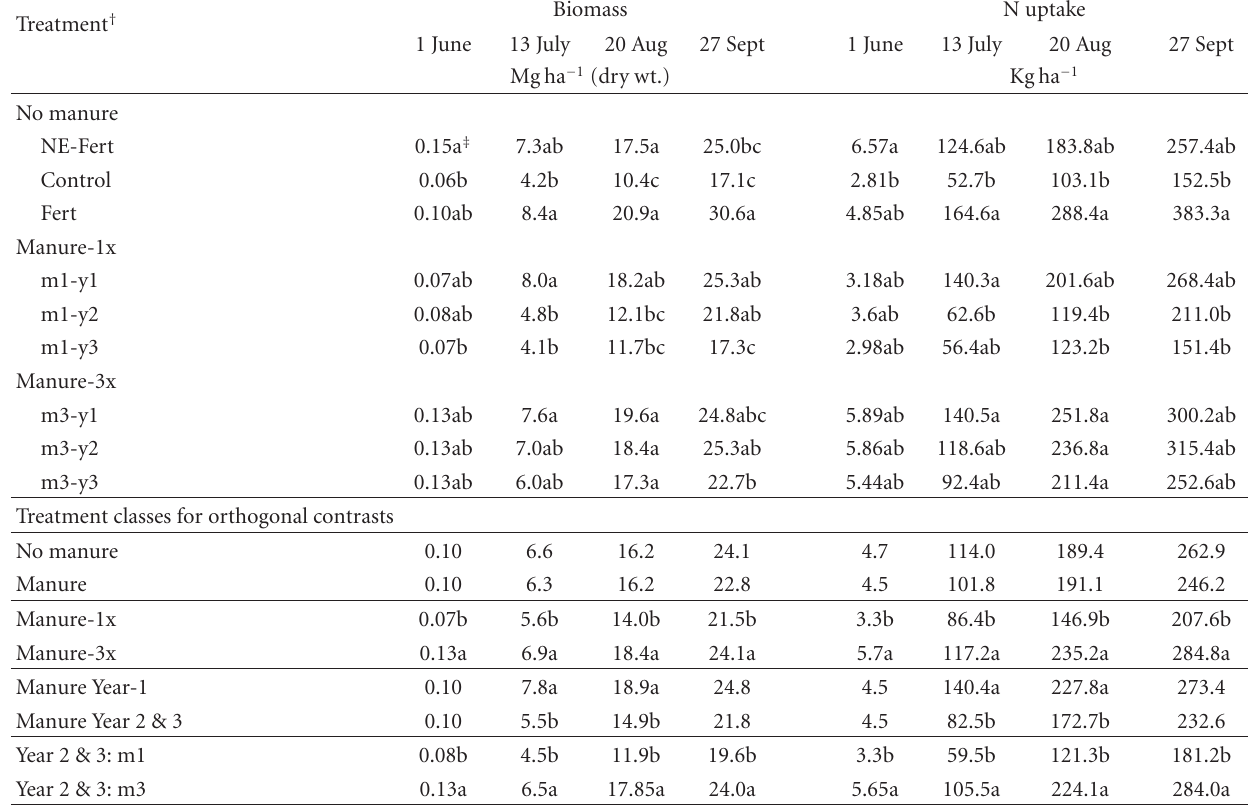
† NE-Fert: noneroded fertilizer (all other treatments on eroded soil); m1: manure-1x; m3: Manure-3x; y1, y2, y3: fall manure applied 1, 2, and 3 years in the past, respectively; manure: m1 + m3; no manure: NEFert + Control + Fert. ‡ Within a given plant component and sample date, treatment means followed by the same lower case letter are not significantly di ff erent ( P < 0 . 05). Not displayed if e ff ect was not significant in the ANOVA (Table